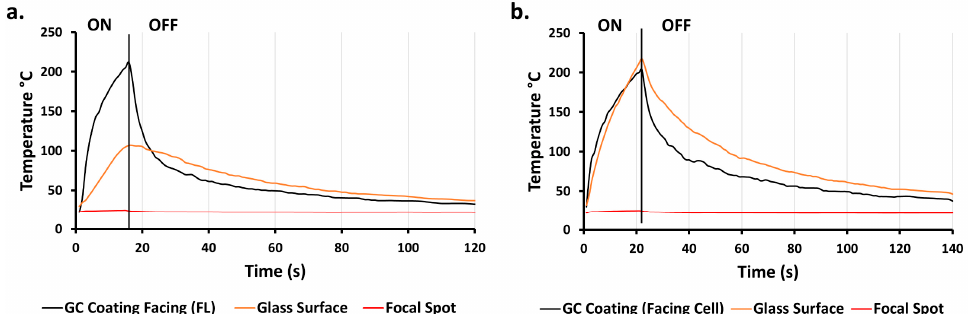
Figure 3. GC 9.3 sample emplaced towards ( a ) the source of solar irradiance and ( b ) polycrystalline cell, respectively.